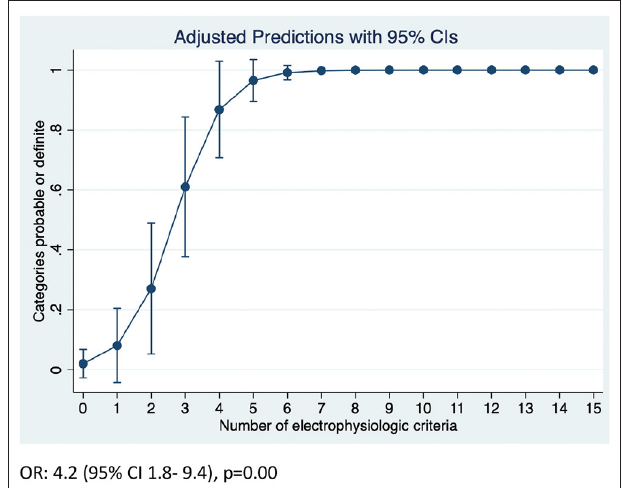
FIGURE 2 | Predicted probability of attaining definite or probable categories according to EFNS/PNS criteria.